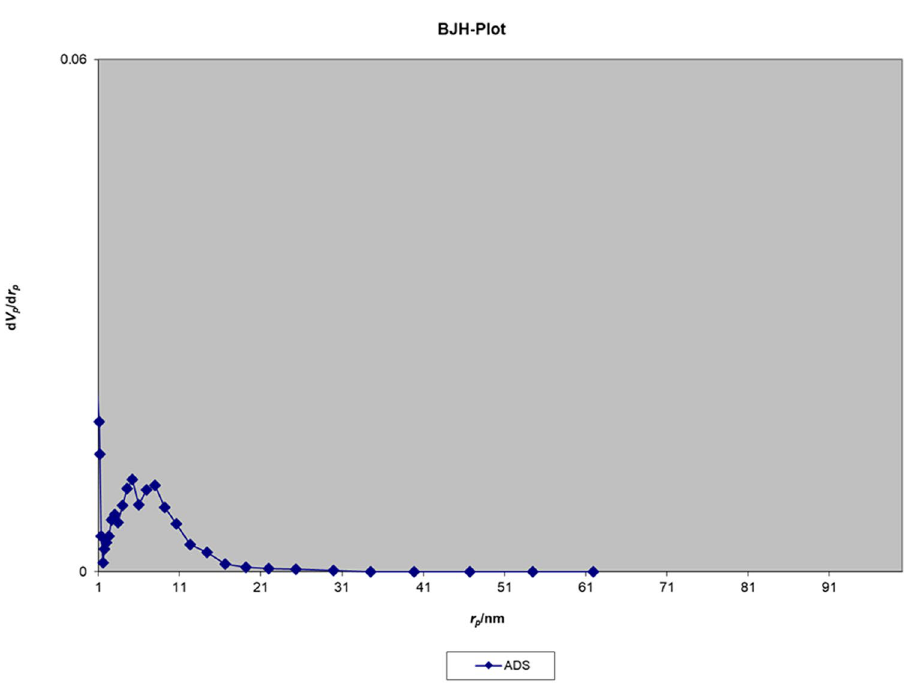
Figure 22. BJH pore size distribution isotherm of the Fe 3 O 4 @Void@m.SiO 2 nanomaterial after adsorption